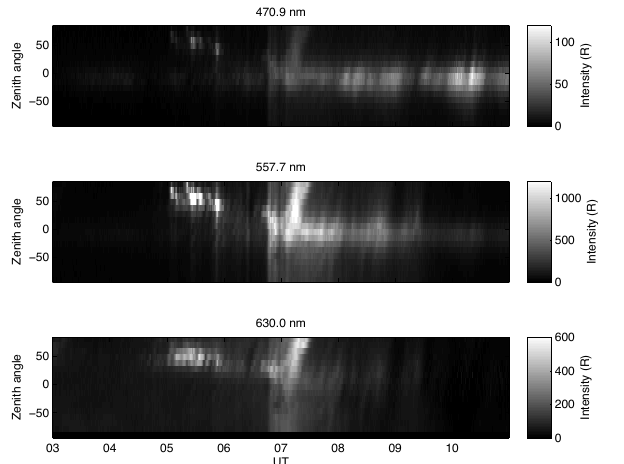
Fig. 5. MSP measurements at Gillam during substorm 1. Dis- played auroral emissions have been captured at the wavelengths of 470.9nm (top), 557.7nm (middle) and 630.0nm (bottom). The negative zenith angles are towards the south and positive towards the north (top of the panel).